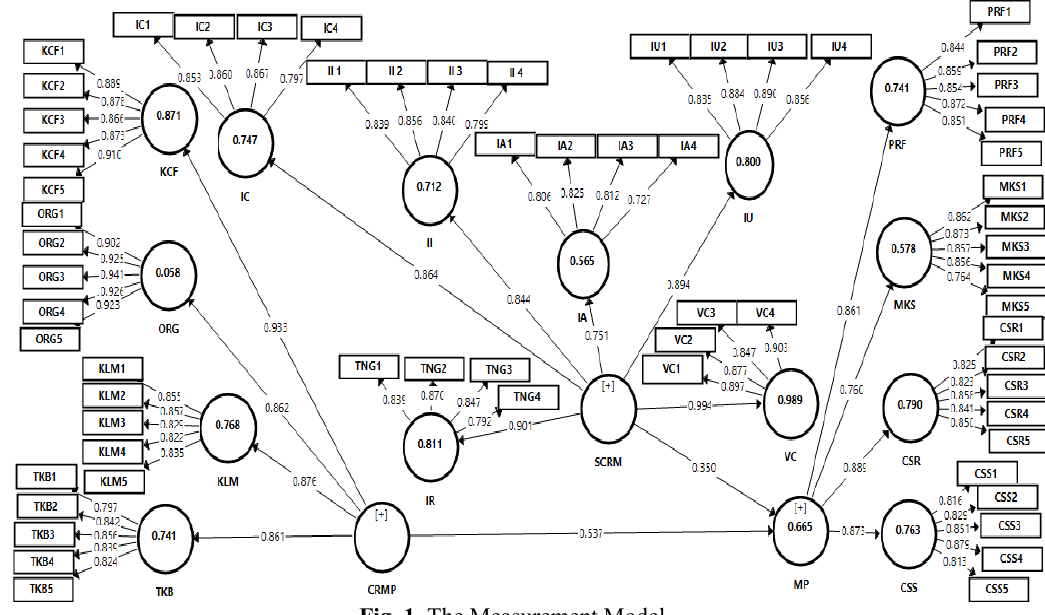
Fig. 1 . The Measurement Model